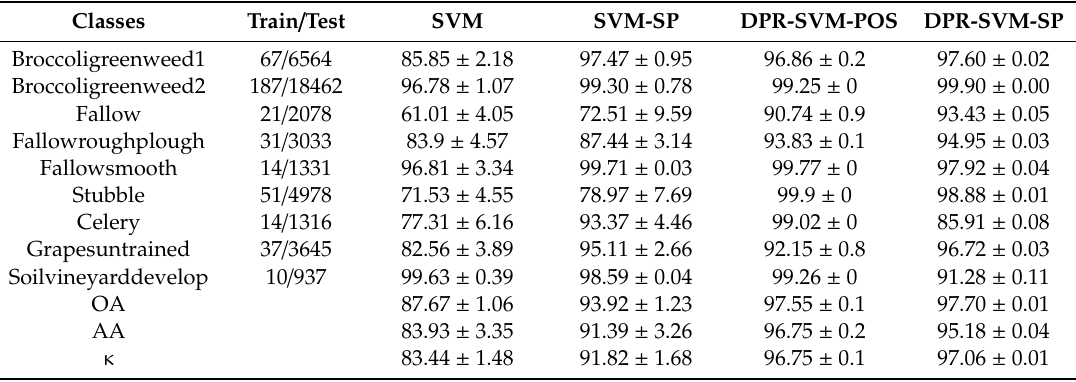
Table 3. Statistical results (mean and standard deviation in percent) of 10 independent classifications provided by SVM, SVM-SP, DPR-SVM-POS and DPR-SVM-SP on Pavia University datasets with 1% labeled samples per class, s = 9 and β = 0.2.